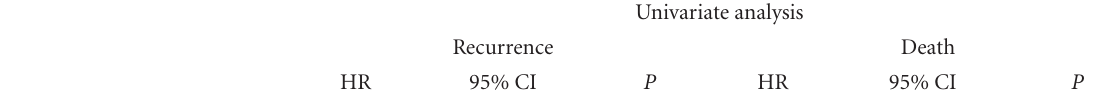
Table 1: Clinicopathologic features of the patients included in the gene expression microarray analysis.